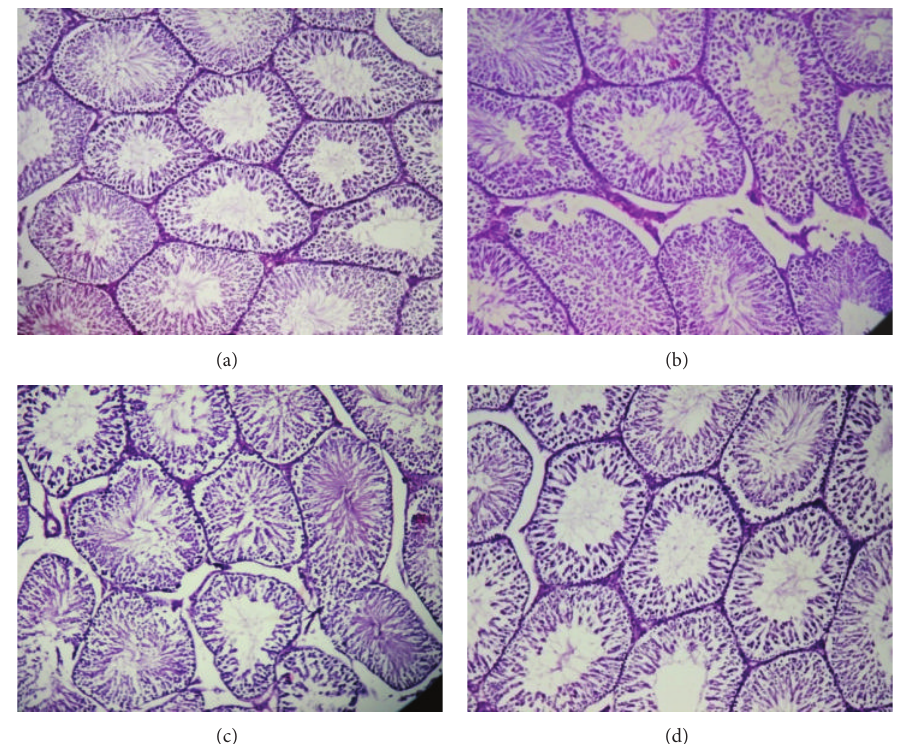
Figure 5: Histology of testis (H&E, 100x) of control and OSE-treated animals. (a) Section of testis from control animal showed well-layered seminiferoustubuleswithgermcell;((b),(c),and(d))testisfromOSE(200,400,and800 mg/kg)-treatedanimalsexhibitnormalseminiferous tubules with germ